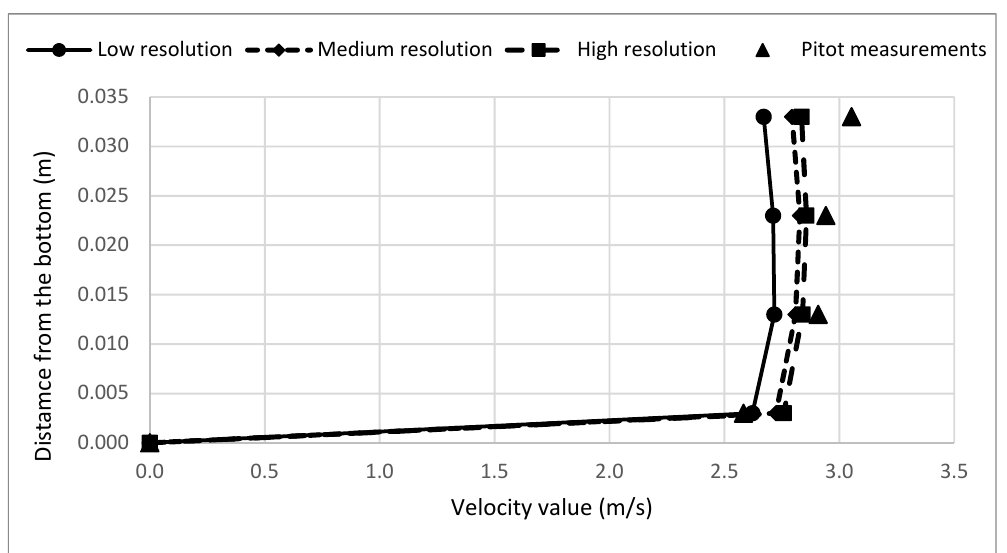
Figure 15. Comparison between the velocity profiles reconstructed with Model #2 at three different resolutions and Pitot measurements at location 1.639 m downstream from the chute.